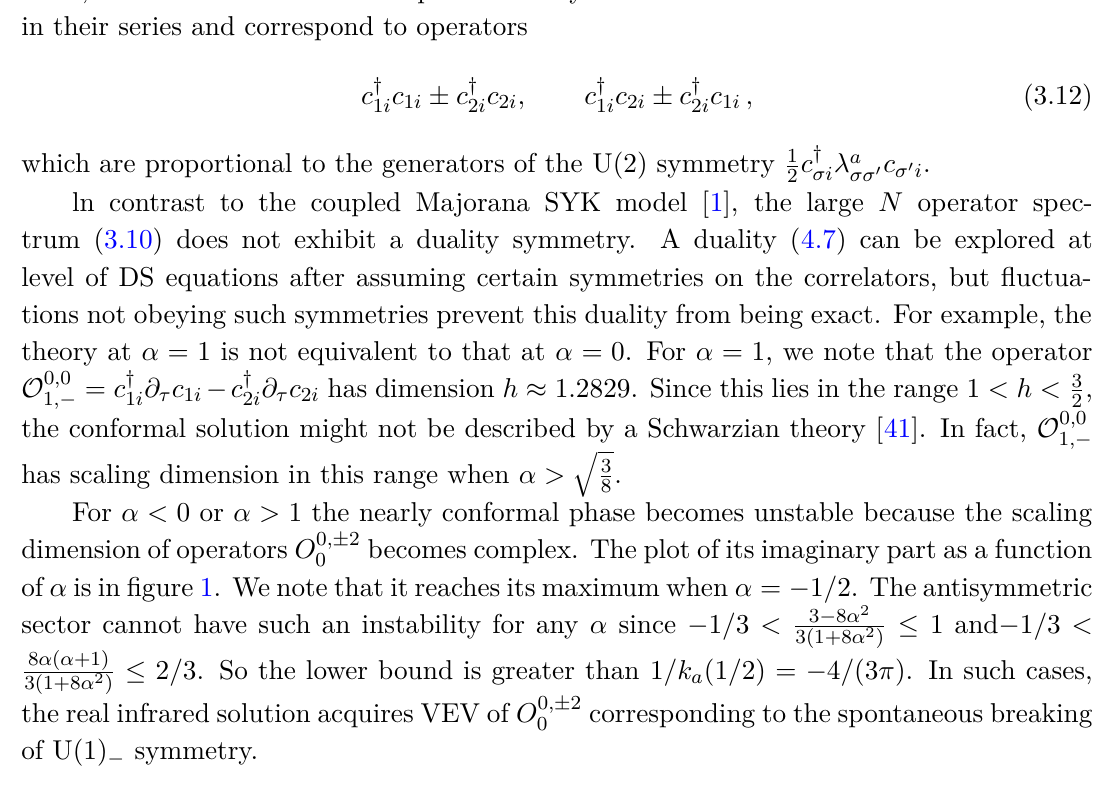
Figure 1 . The imaginary part of the scaling dimension of operator c † at α = − 1 / 2